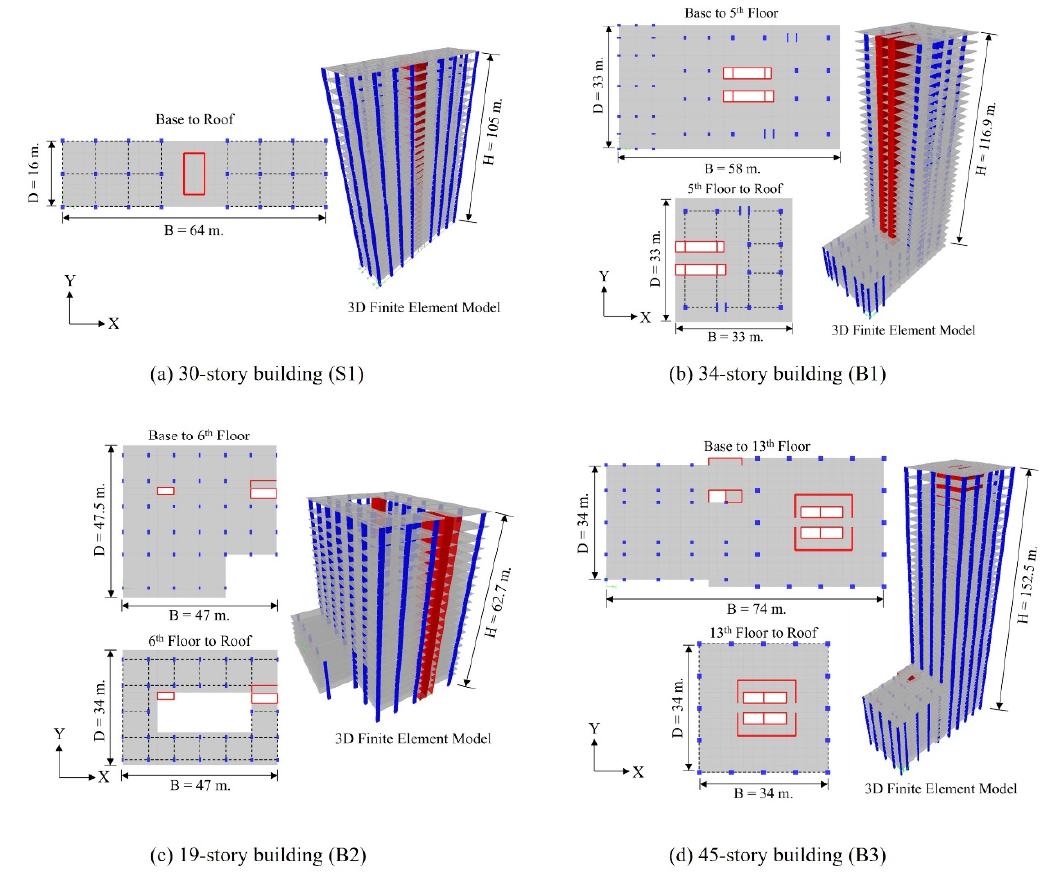
Figure 3. Typical floor plans and 3D views of the four case study